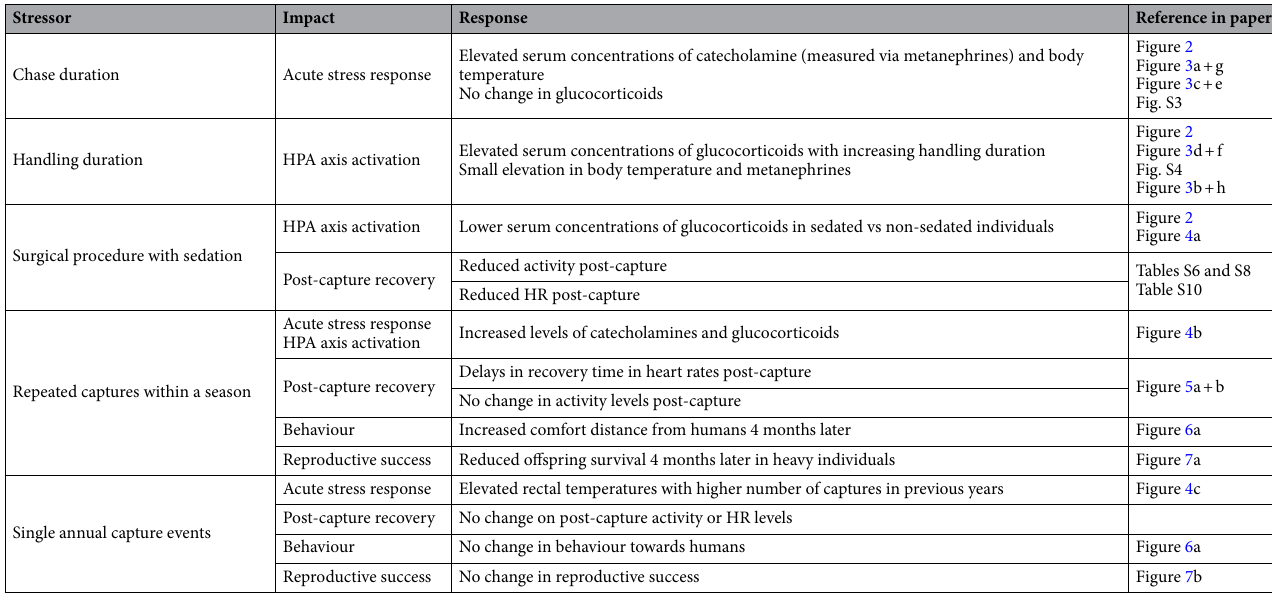
Table 1. Summary of responses to handling and repeated captures in female Svalbard